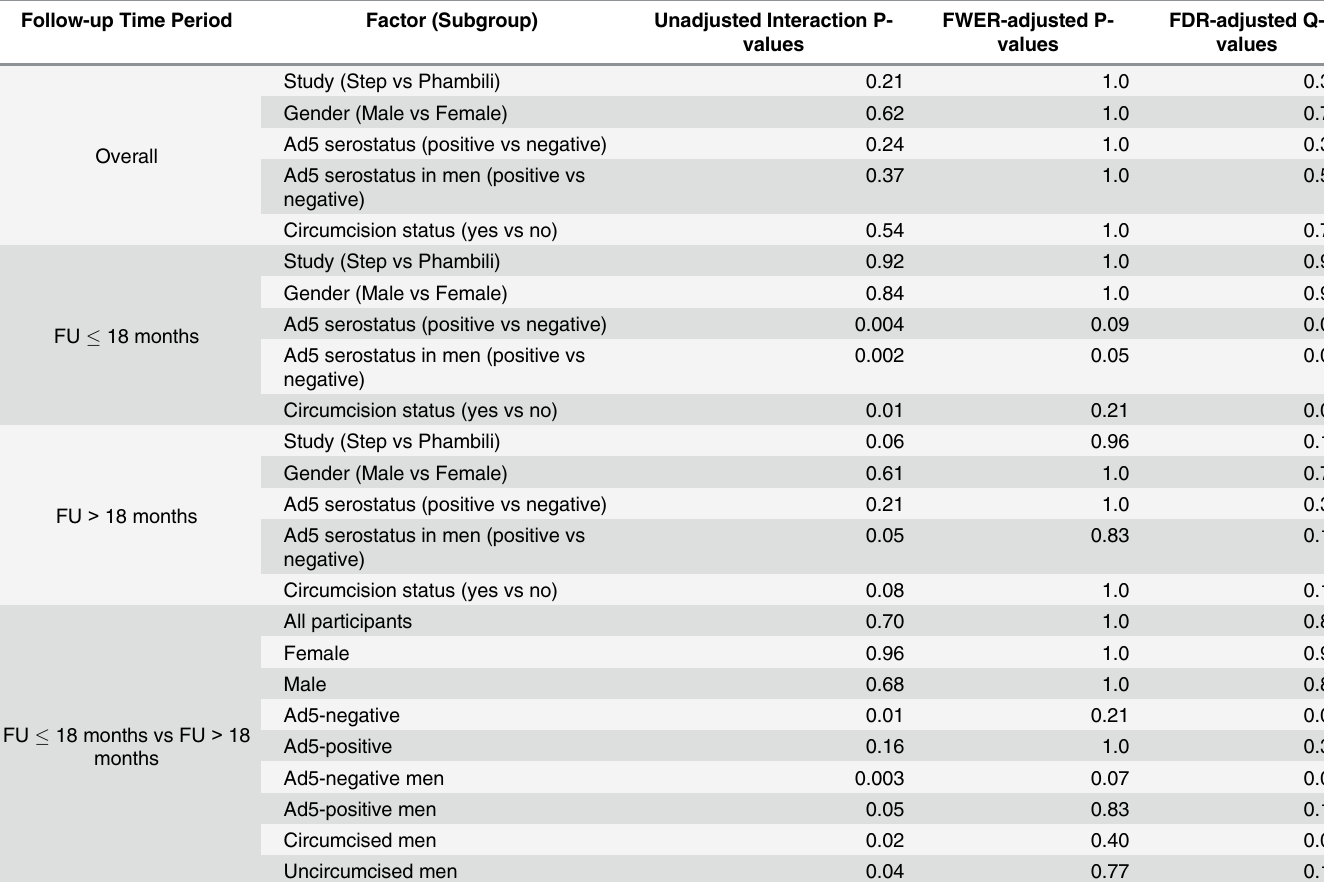
Table 3. Unadjusted and Multiplicity-Adjusted P-values from Interaction Tests of Differential Vaccine Effect by Follow-up Time Period and Sub- group Based on Step and Phambili. Holm-Bonferroni family-wise-error-rate (FWER)-adjusted p-values and false-discovery-rate (FDR)-adjusted q-values are reported in the last two